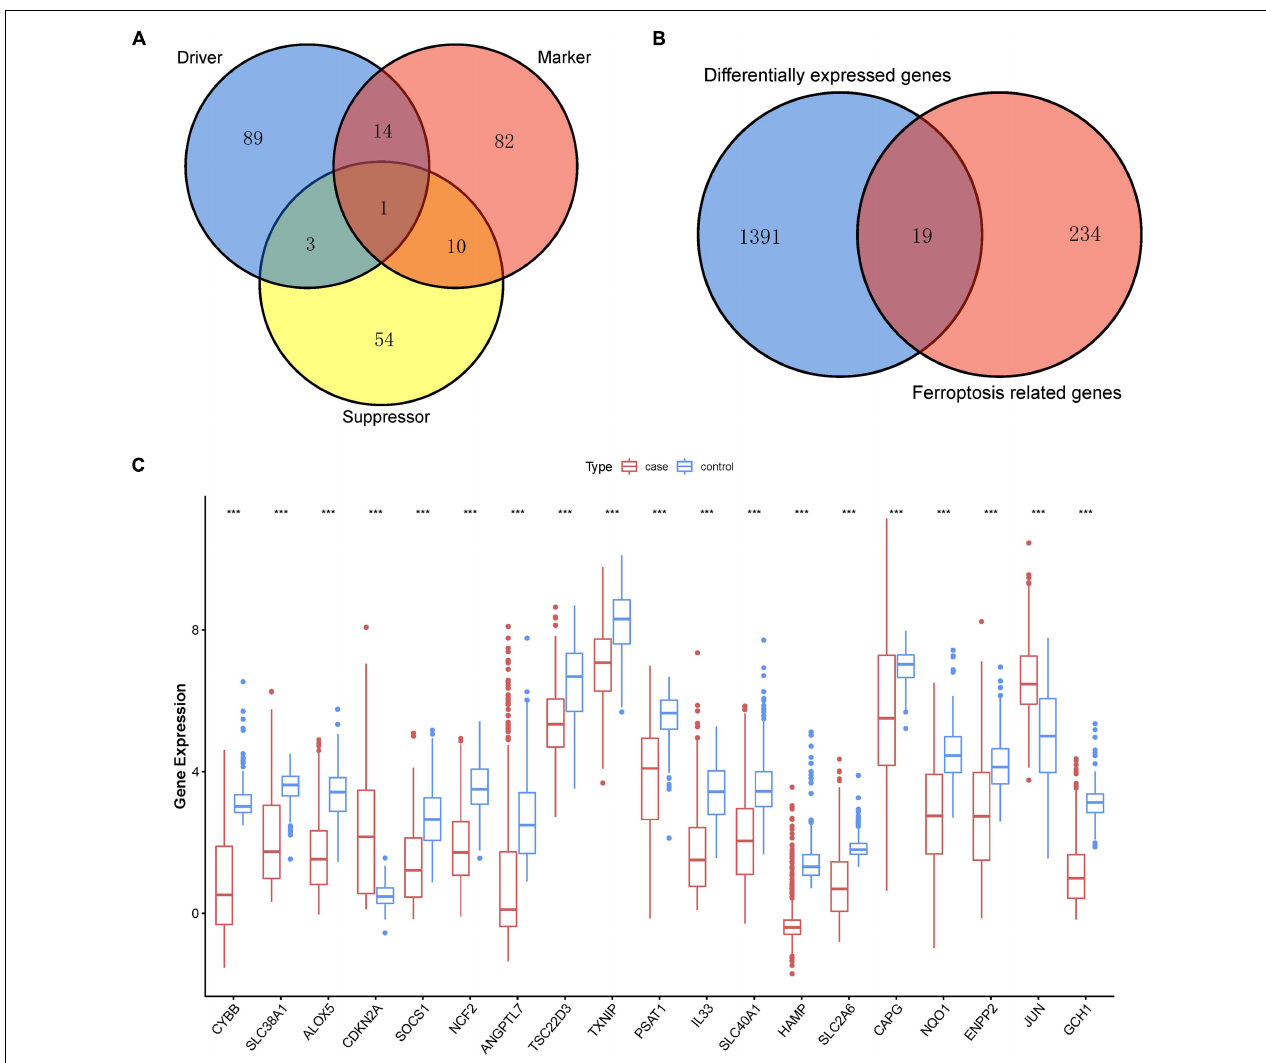
FIGURE 2 | Identification of ferroptosis-related DEGs. (A) A Venn diagram showed ferroptosis-linked genes consisting of drivers, markers, and suppressors. (B) A Venn diagram illustrating that 19 ferroptosis-linked DEGs were uncovered in The Cancer Genome Atlas (TCGA) and Genotype-Tissue Expression (GTEx) Project data sets. (C) Box plot representing the gene expression indexes of the ferroptosis-related DEGs; red for tumor group, and blue for normal group; the X-axis showed the 19 ferroptosis-related genes, and the Y-axis represented the expression level of genes. Wilcox test was employed to assess the gene expression values between the tumor and normal groups. p < 0.05 signified statistical significance; * p < 0.05; ** p < 0.01; *** p <